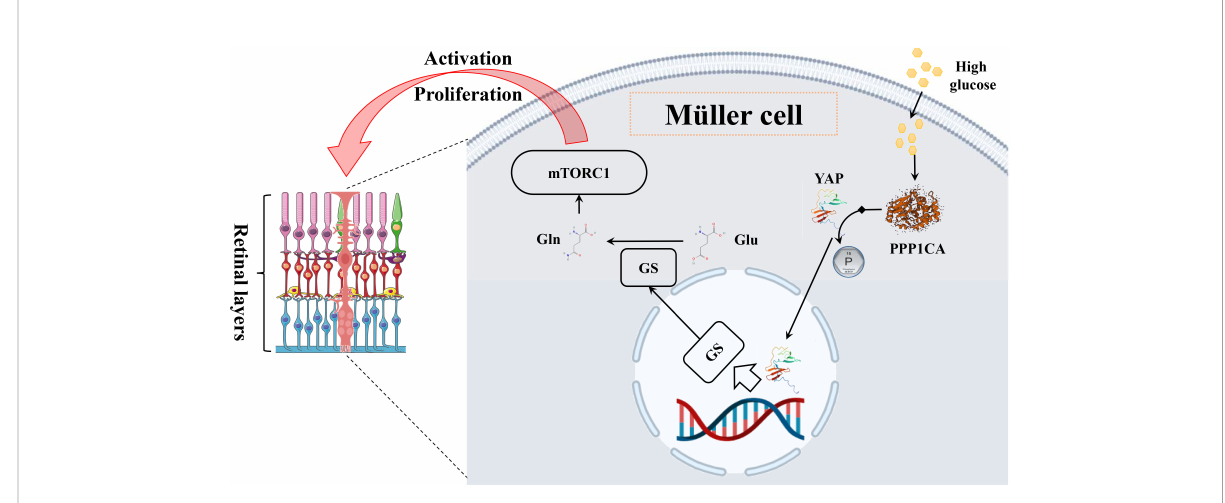
FIGURE 9 The mechanism diagram of glutamine in the Müller cell. In Müller cells, high glucose leads to an elevated level of glutamine through the PPP1CA – YAP – GS – Gln – mTORC1 pathway, subsequently activating cells and